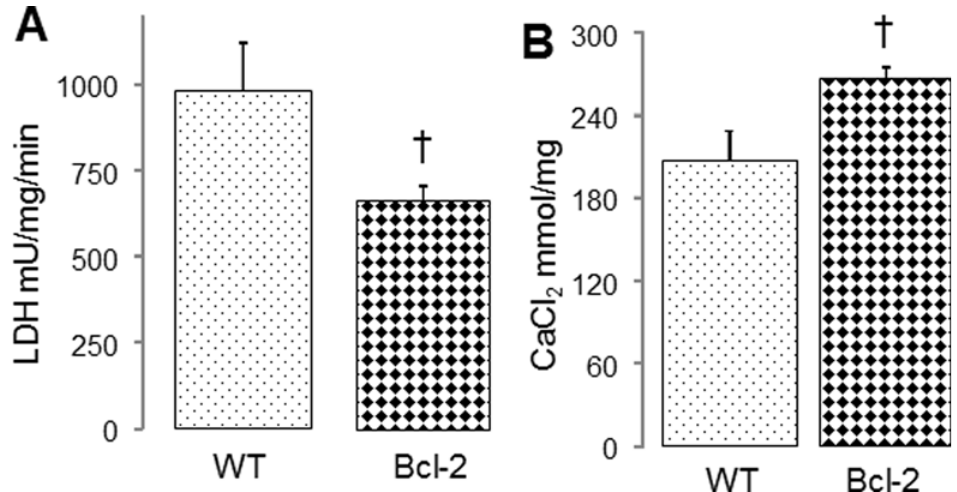
Fig 5. Overexpression of bcl-2 improves the CRC in mitochondria following ischemia-reperfusion. Panel A: The LDH content in coronary effluent in bcl-2 overexpressed mice following 40 min global ischemia and 30 min reperfusion was much lower than that in wild type, supporting that overexpression of bcl-2 reduces cell injury during ischemia-reperfusion. Panel B: Overexpression of bcl-2 improves the CRC in mouse SSM following ischemia-reperfusion compared to wild type, indicating that the sensitivity to MPTP opening is decreased in mitochondria from bcl-2 overexpressed mouse heart. (Mean ± SEM; * p < 0.05 vs. pre-ischemia; † p < 0.05 vs. wild type; n = 6 in each